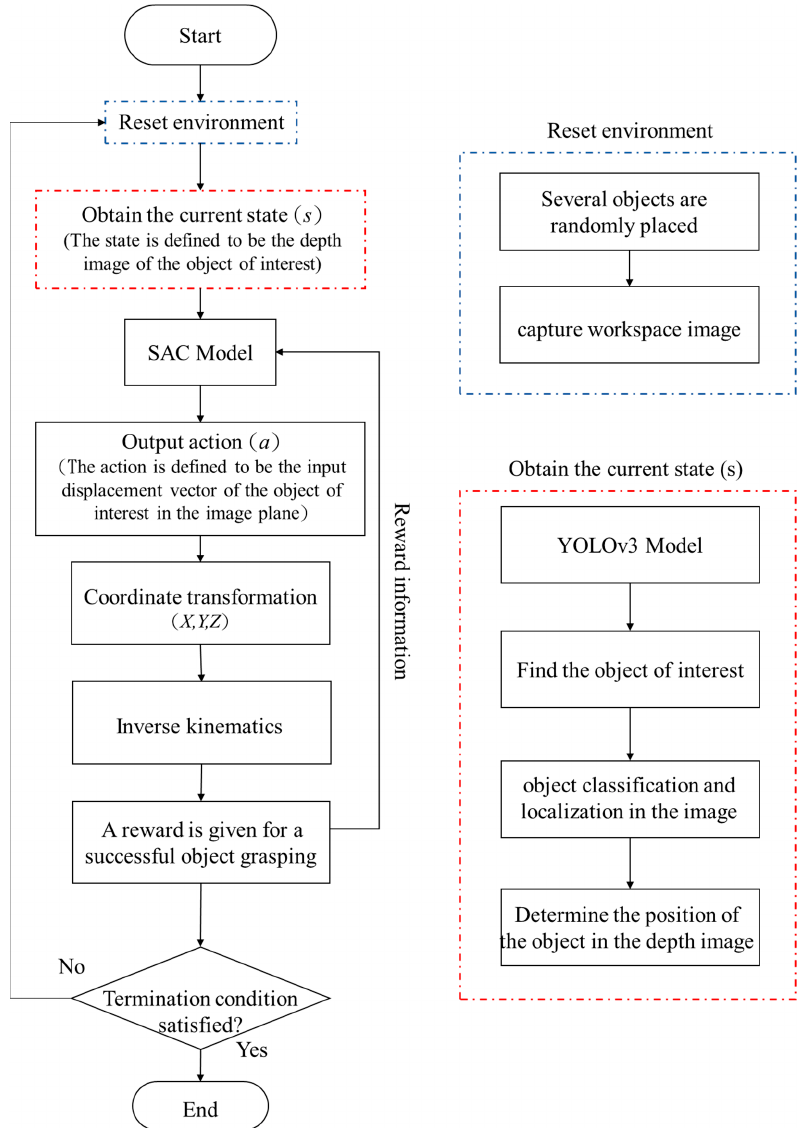
Figure 12. Flowchart of the training process for the proposed object grasping approach based on SAC.